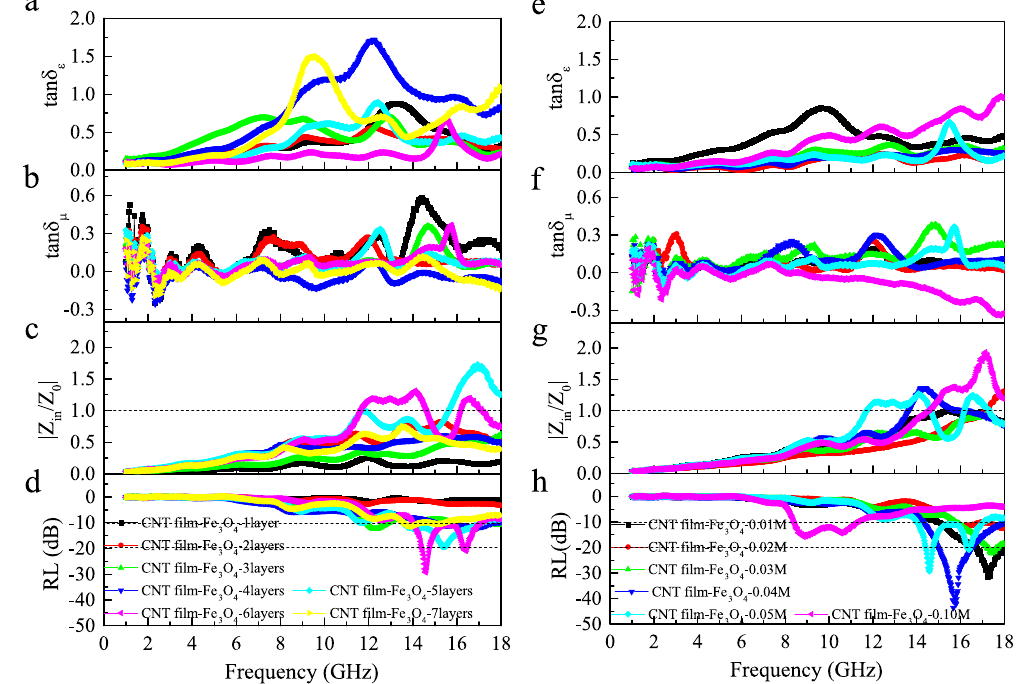
Figure 4. ( a ) Dielectric tangent loss, ( b ) magnetic tangent loss, ( c ) impedance matching coefficient |Z in /Z 0 | and ( d ) reflection loss of the CNT film-Fe 3 O 4 composites with one, two, three, four, five, six and seven layers prepared from 0.05 M FeCl 3 . ( e ) Dielectric tangent loss, ( f ) magnetic tangent loss, ( g ) impedance matching coefficient |Z in /Z 0 | and ( h ) reflection loss of the CNT film-Fe 3 O 4 composites with six layers prepared from 0.01, 0.02, 0.03, 0.04, 0.05 and 0.10 M FeCl 3